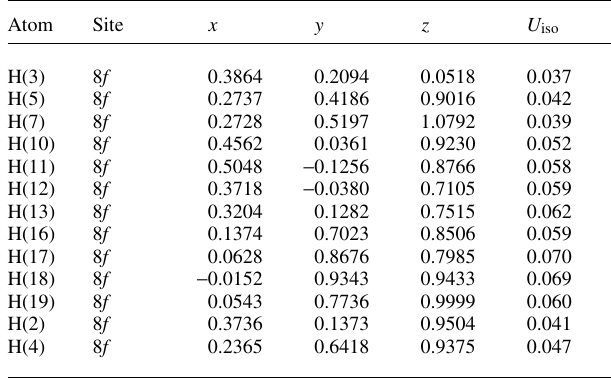
Table 2. Atomic coordinates and displacement parameters (in Å 2 )